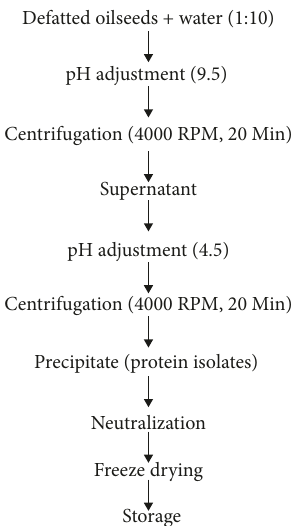
Figure 1: Systematic flow sheet for oilseed protein isolate preparation.